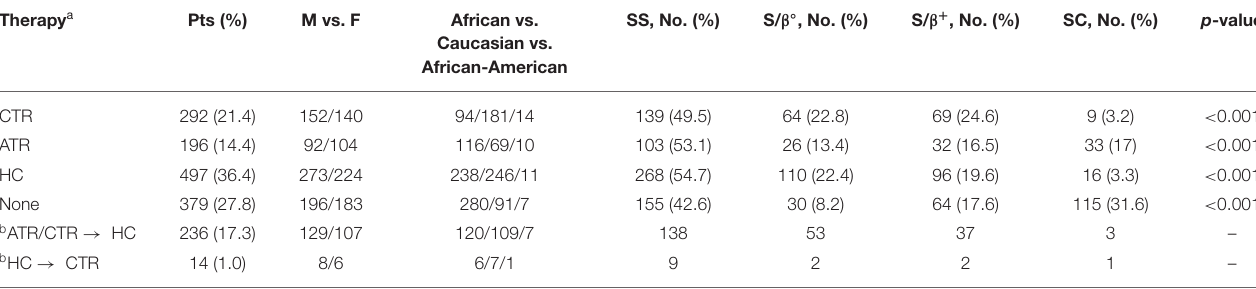
TABLE 2 | Treatments of SCD patients ( n = 1,364) and distribution according to ethnicity and genotype. Therapy a M vs. F African vs. Caucasian vs.